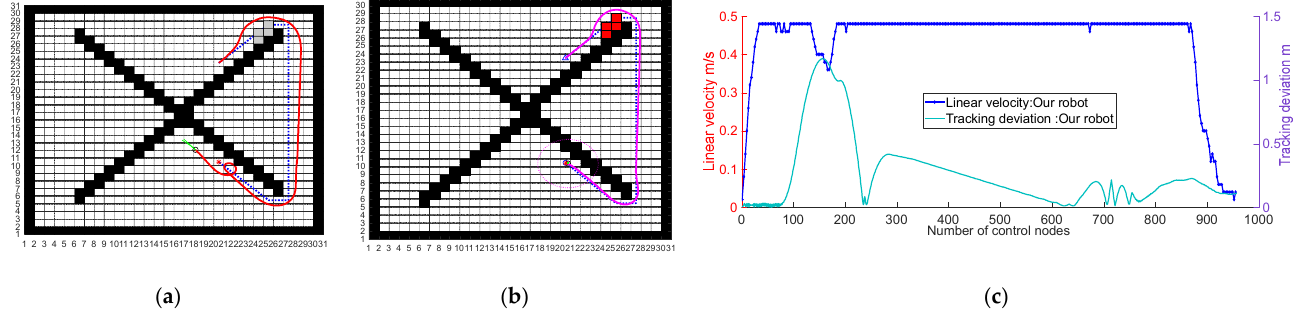
Figure 15. Map 2’s Experimental results. ( a ) Traditional robot. ( b ) Our robot. ( c ) Two-coordinate plot of linear velocity and tracking deviation.